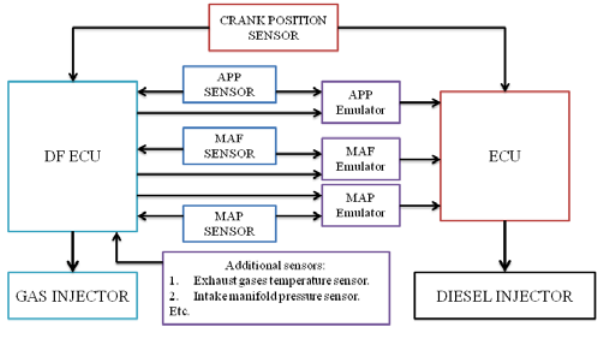
Fig. 3. Dual fuel mode control setup